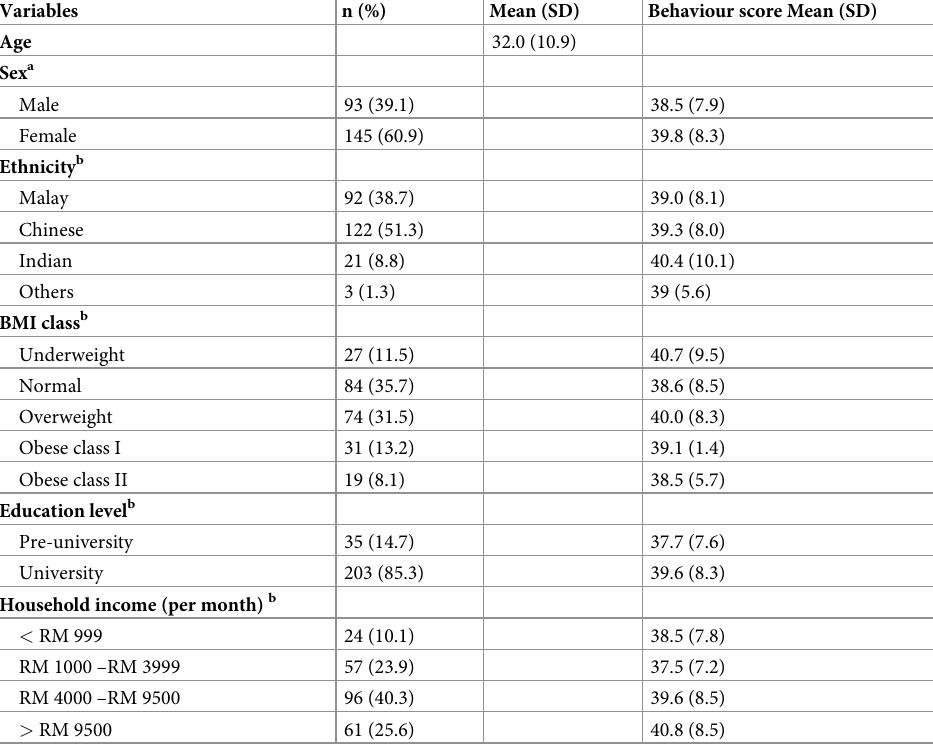
Table 1. Participant socio-demographics and self-care behaviour.